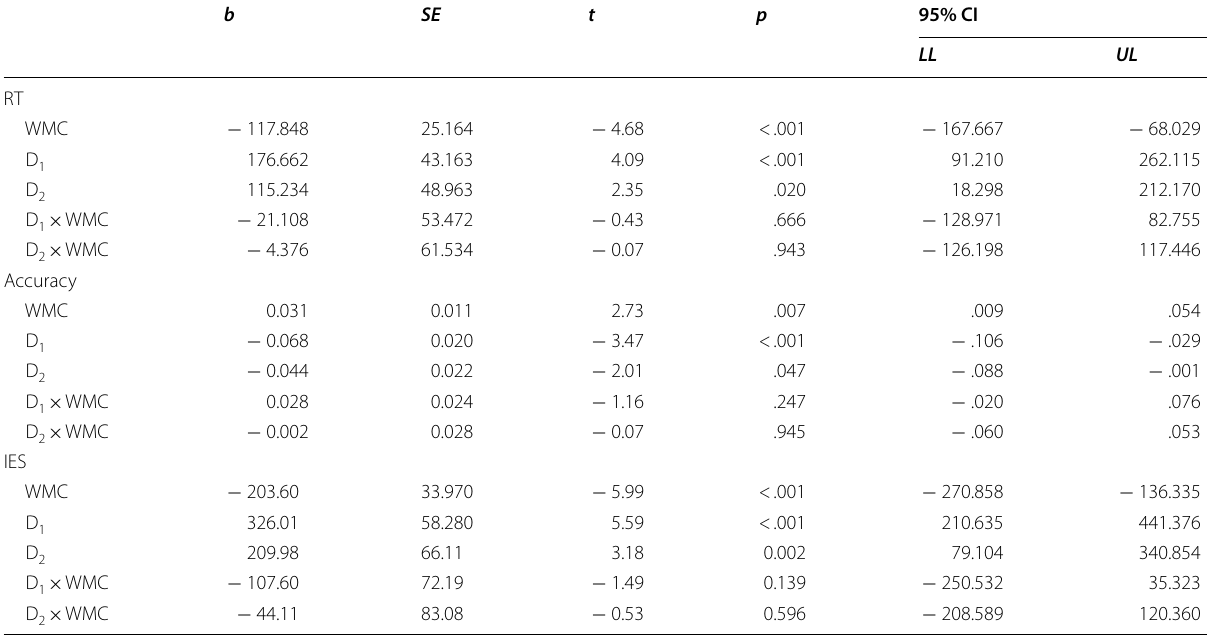
Table 3 Regression (moderation) analysis predicting RTs, accuracy rates, and IESs of tactical decision-making under distraction (Helmert